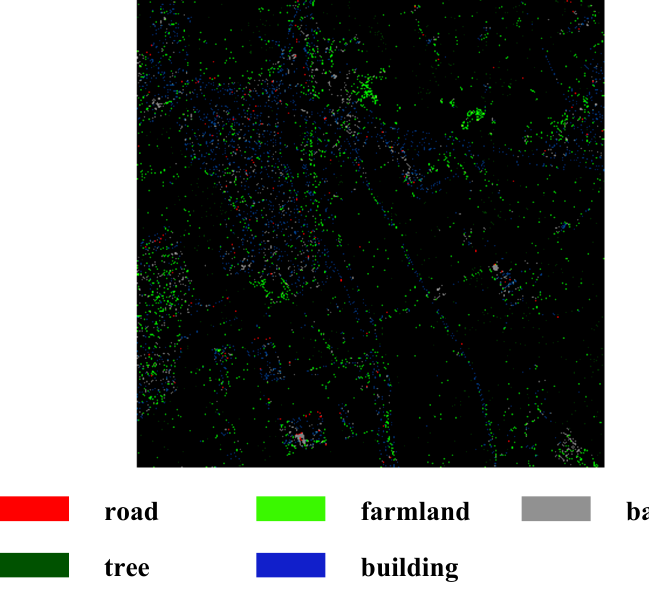
Figure 5. Differences between HDCA and SVM.